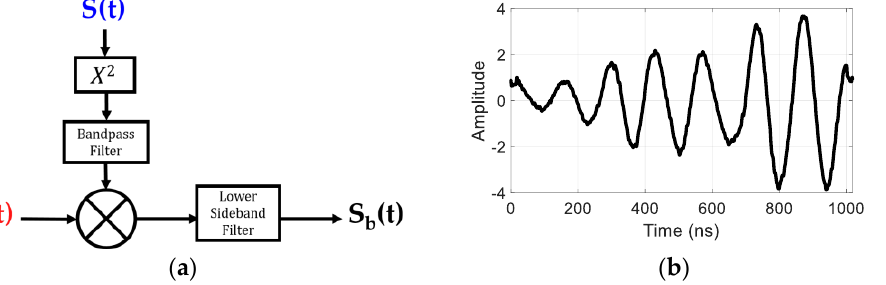
Figure 10. ( a ) Process of extracting the beat signal and ( b ) the extracted beat signal.